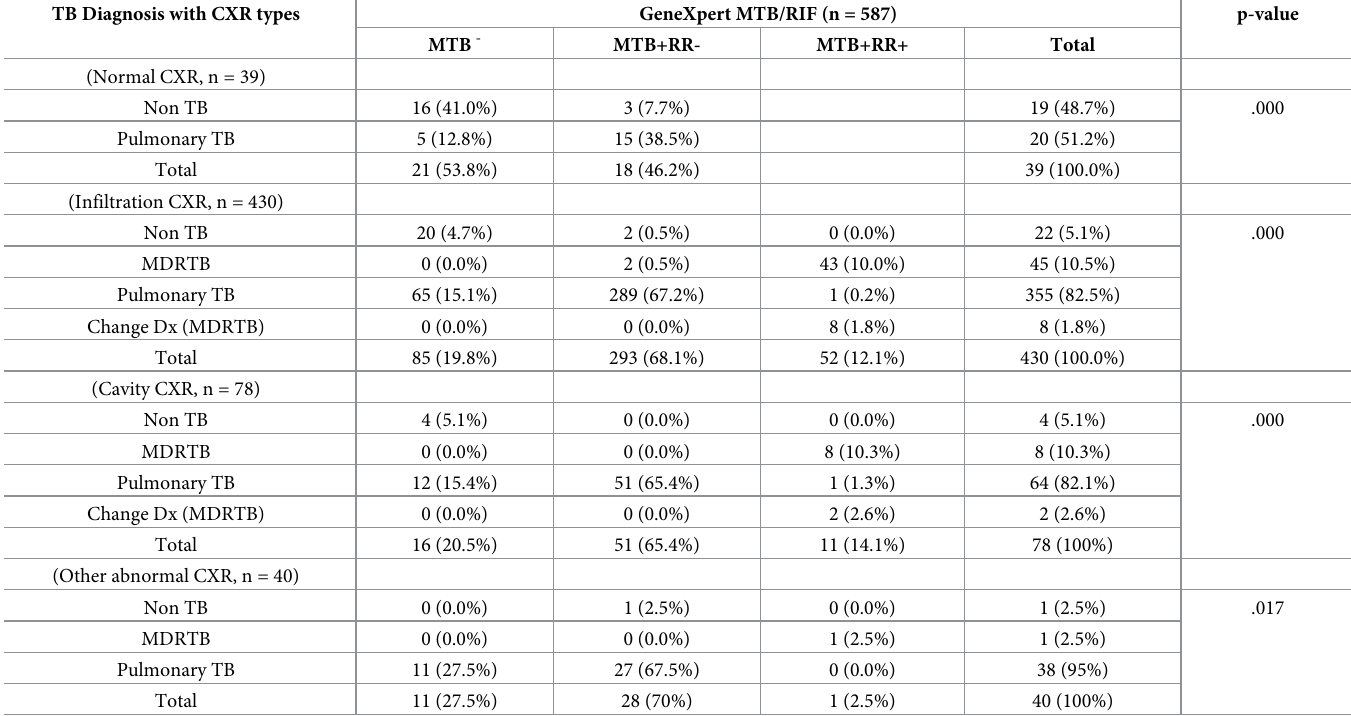
Table 2. Comparisons of TB diagnosed among high risk of MDR-TB based on CXR and GeneXpert results (n = 587). TB Diagnosis with CXR